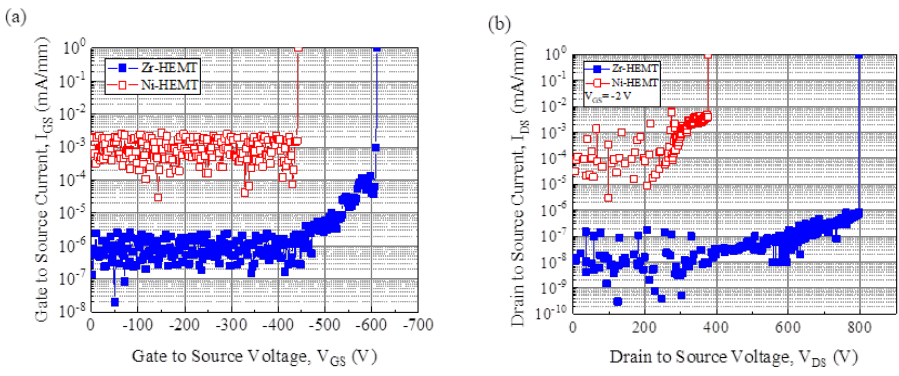
Figure 5. ( a ) Schottky breakdown voltage and ( b ) off-state breakdown voltage of Zr-HEMT and Ni-HEMT.